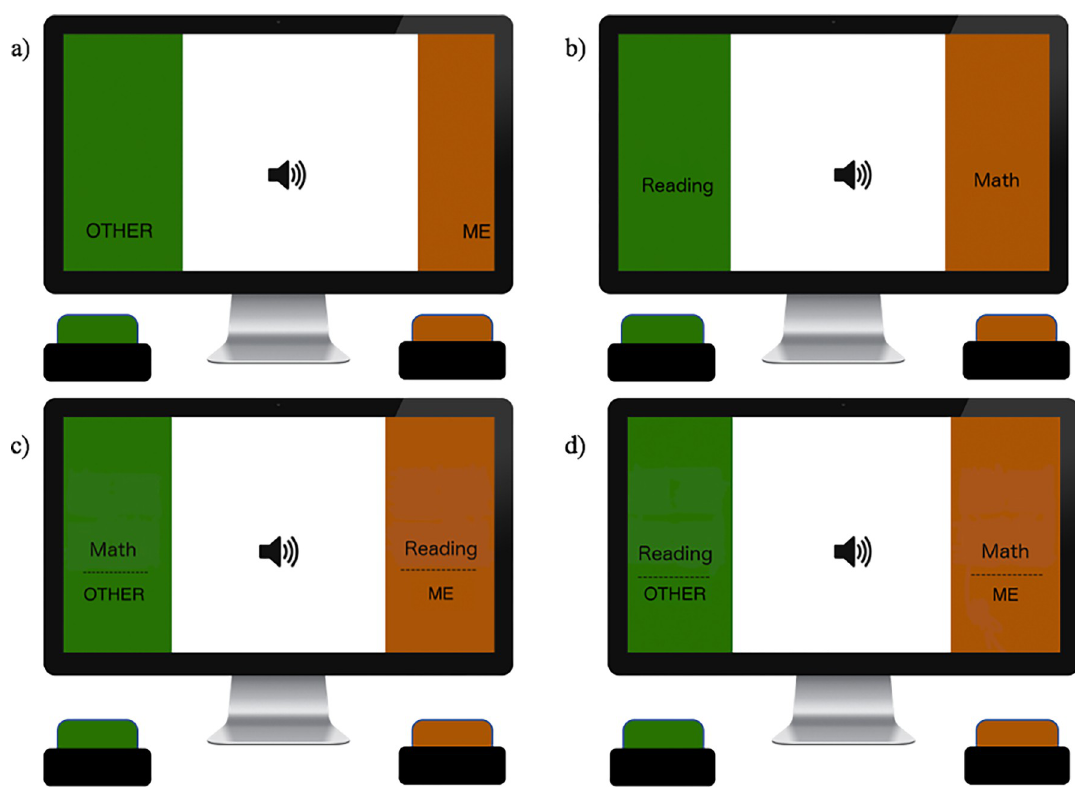
Fig 2. Schematic of implicit math self-concept